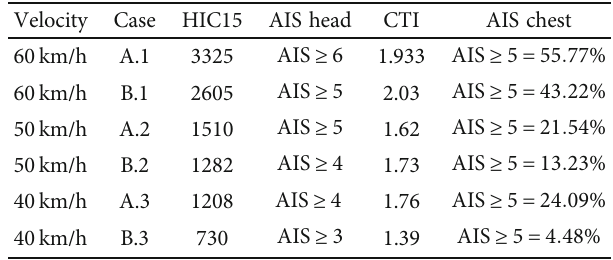
Figure 5: Frame deformation: (a) frame contact with impactor; (b) moment after contact with impactor (maximum permanent deformation); (c) longitudinal displacement of the center of the front scissors ’ axis for frame impact safety test. Table 6: Evaluation of HIC 15 and CTI with and without a passive safety